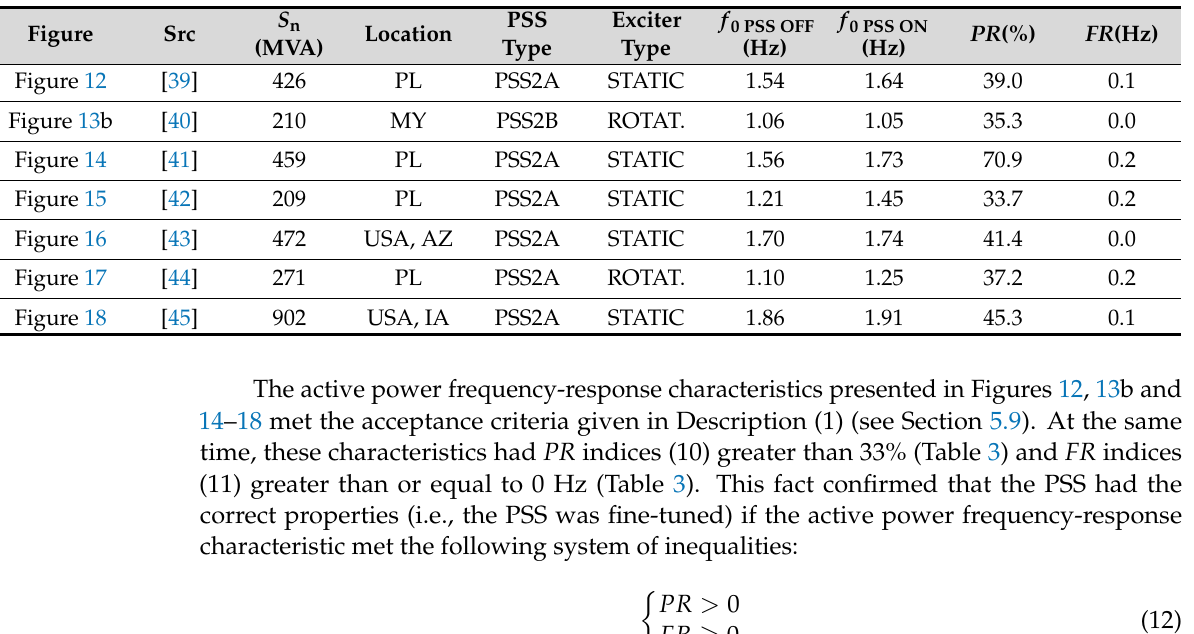
Table 3. Summary of PR and FR indices of the dual-input stabilizer (PSS-P- ω ) characteristics.